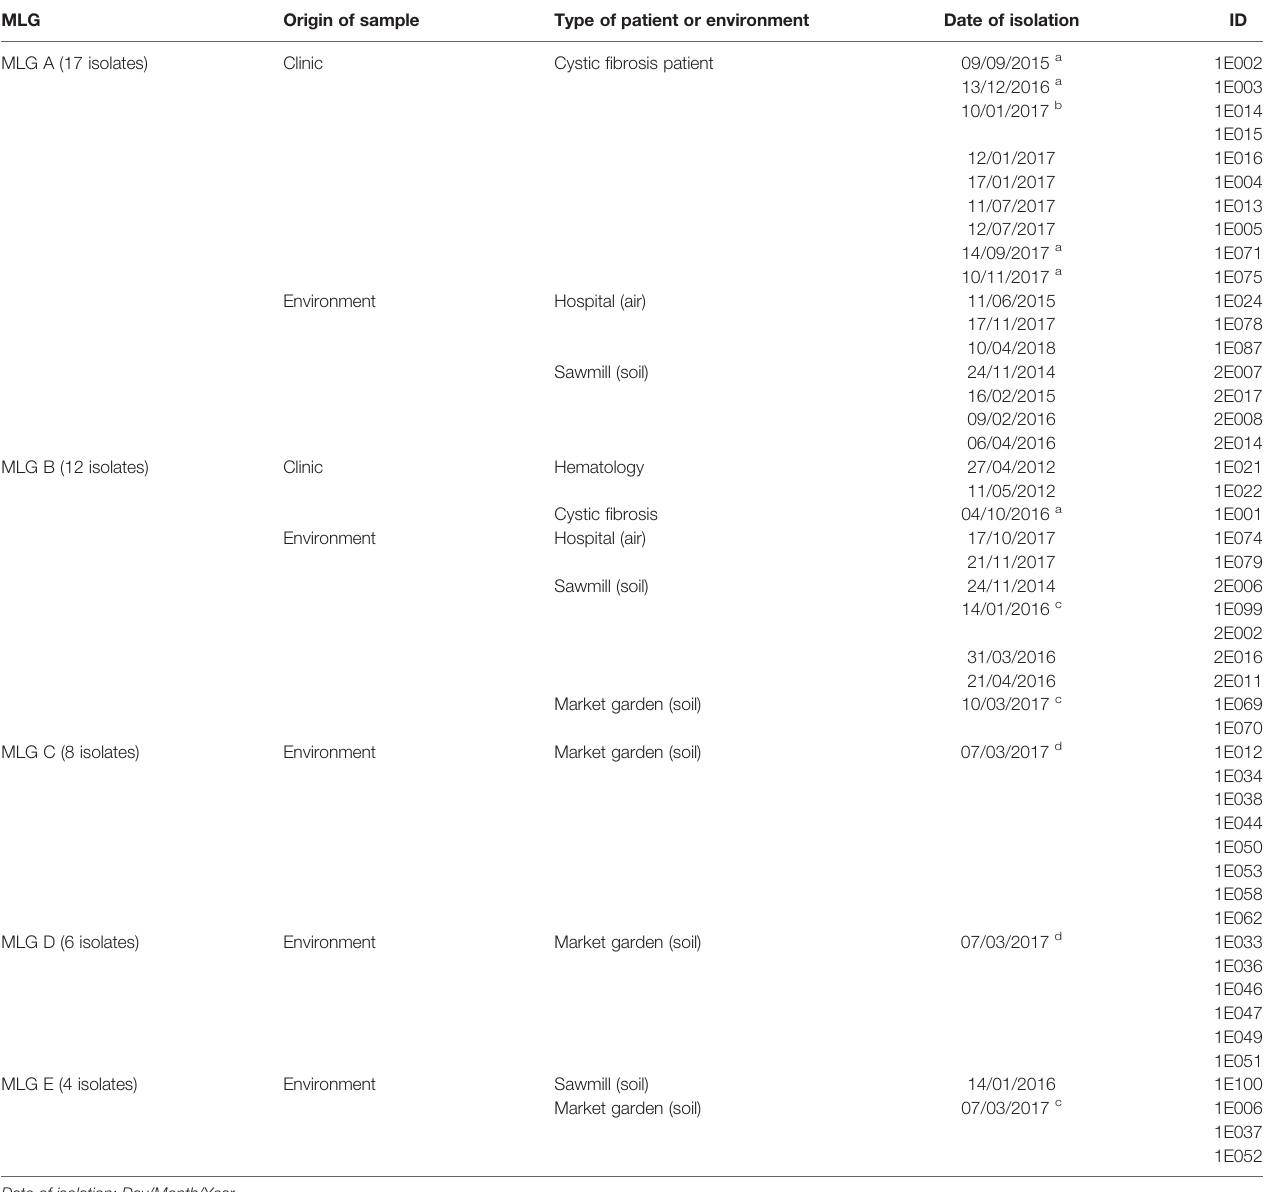
TABLE 3 | Multilocus genotypes (MLG) shared by isolates with TR 34 /L98H allele.